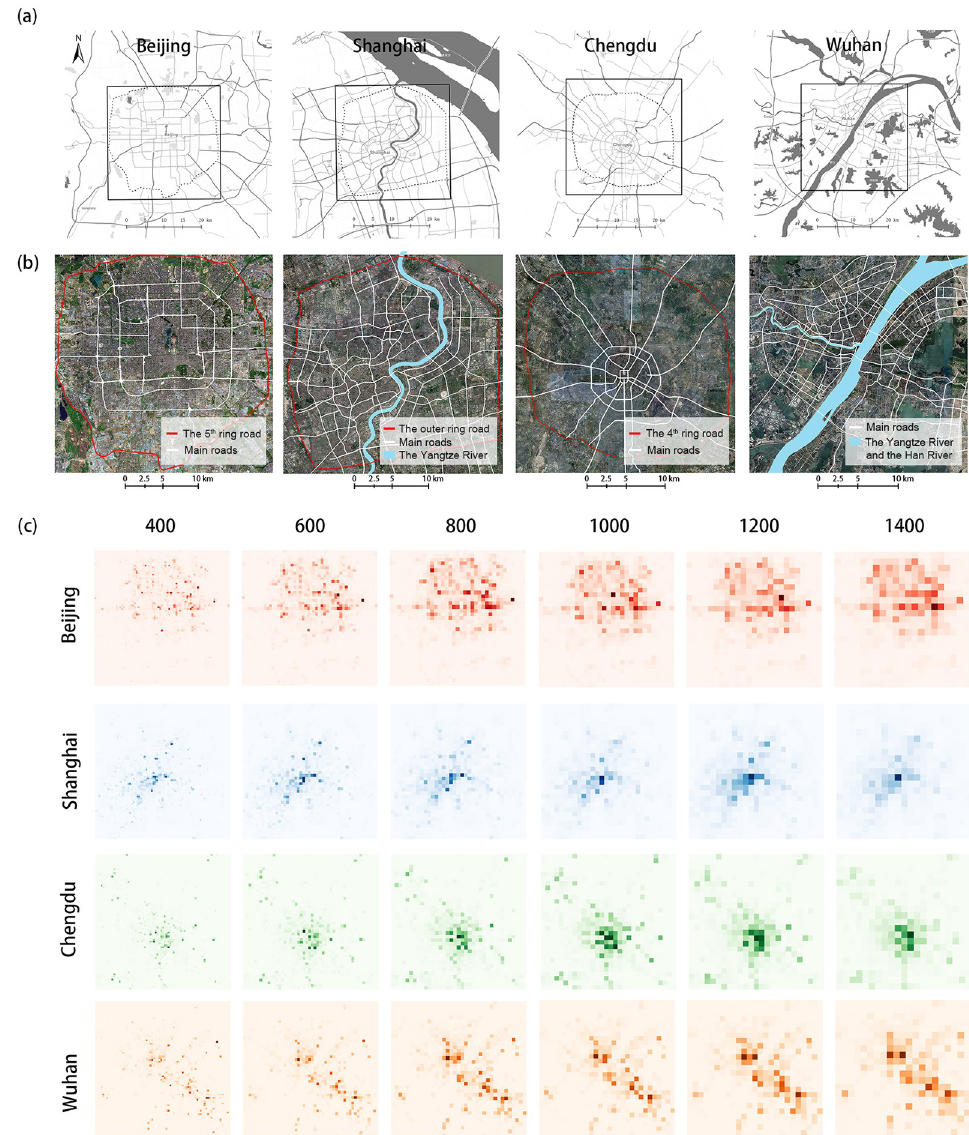
Fig 5. The study areas in Beijing, Shanghai, Chengdu, and Wuhan. (a) the study areas; (b) satellite imagery; (c) spatial distributions of check-in data at varying scales in these cities.